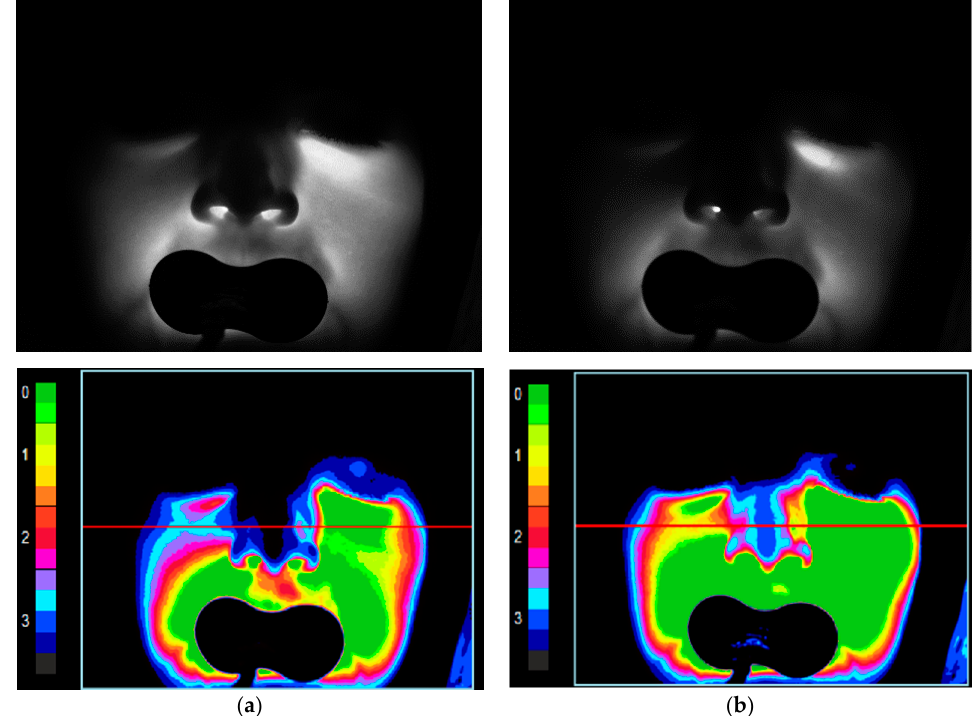
Figure 3. Registered ( top ) and processed ( bottom ) images for a conditionally healthy volunteer 2 (female) at a camera exposure time of 20.7 ms for probing radiation wavelengths of: 650 nm ( a ); and 850 nm ( b ). Preliminary experimental studies using the relevant method MRI have confirmed the sensitivity of the digital diaphanoscopy method in detecting pathological changes in the